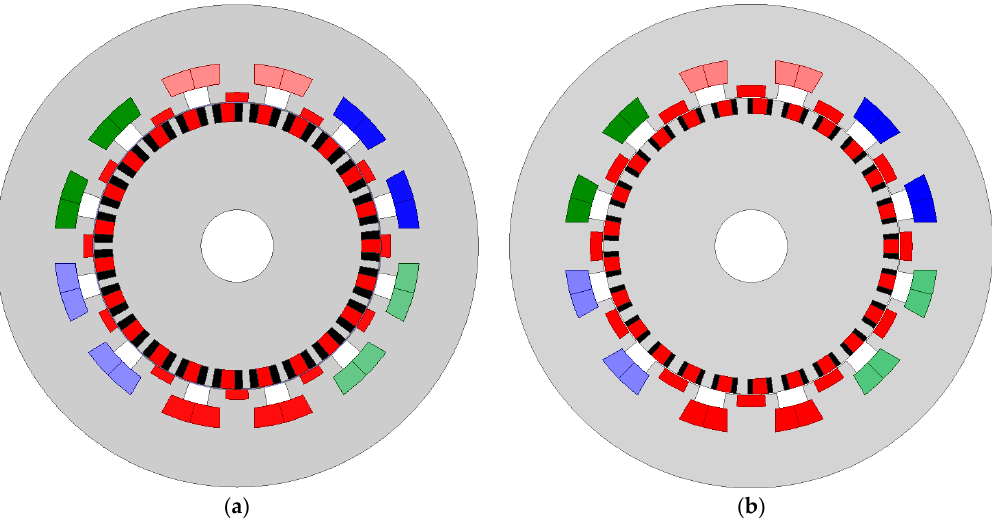
World Electric Vehicle Journal 2020 , 11 , x FOR PEER REVIEW